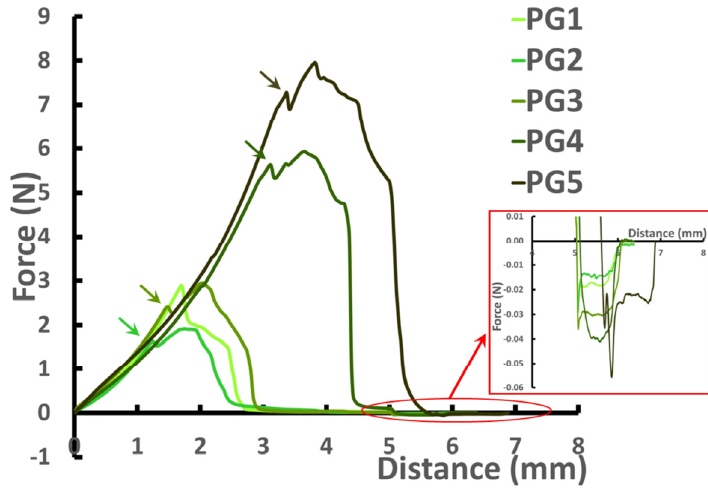
Figure 1. Representative force–distance curves of pectin hydrogels PG1–PG5. The arrows show the first significant break. The insertion window demonstrates the curve area, which corresponded to adhesiveness. Table 4. Mechanical properties of pectin hydrogels PG1–PG5 in the puncture test.